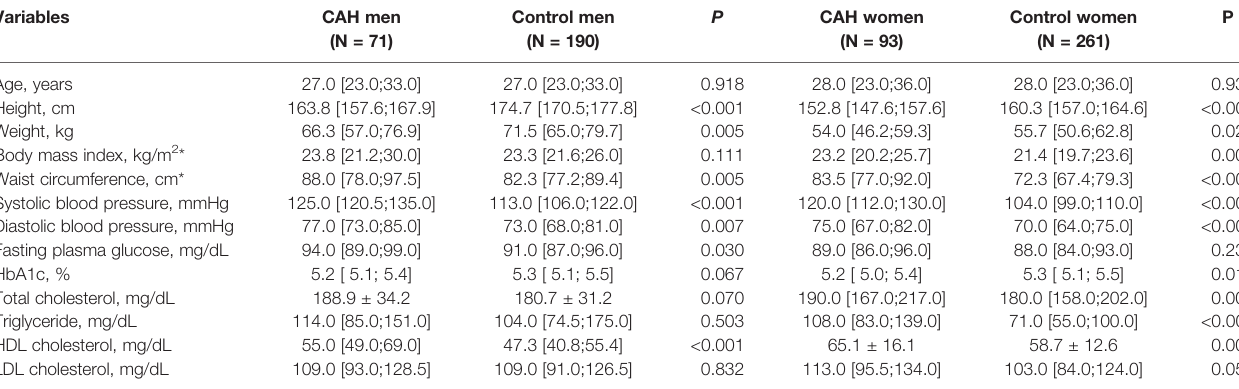
TABLE 1 | Comparison of clinical characteristics between CAH patients and age- and sex-matched control.